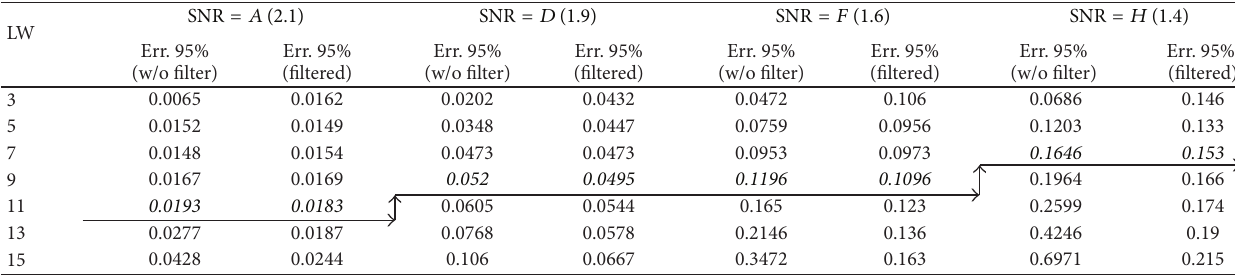
Figure 14: Pixel error levels for various line widths and different image SNRs.